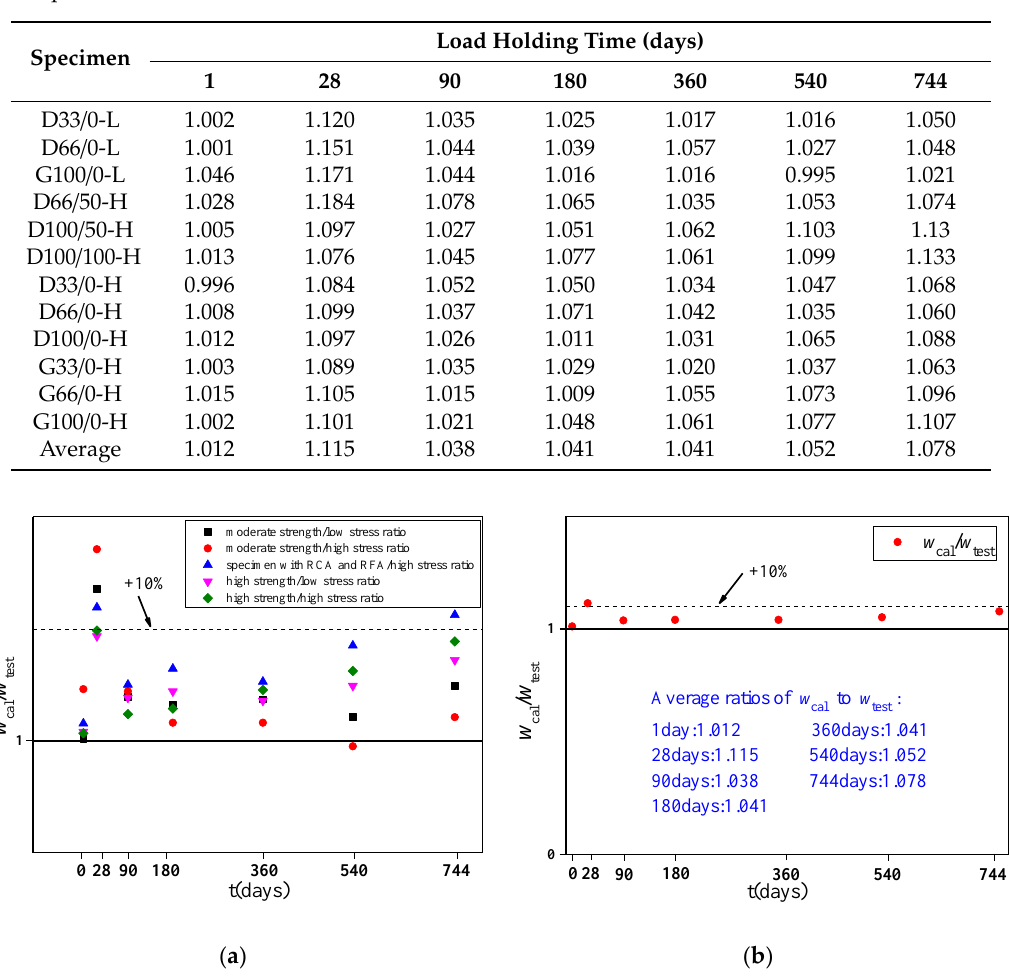
Table 8. Ratio of the calculated deflection to the measured deflection of the specimens in di ff erent time periods.